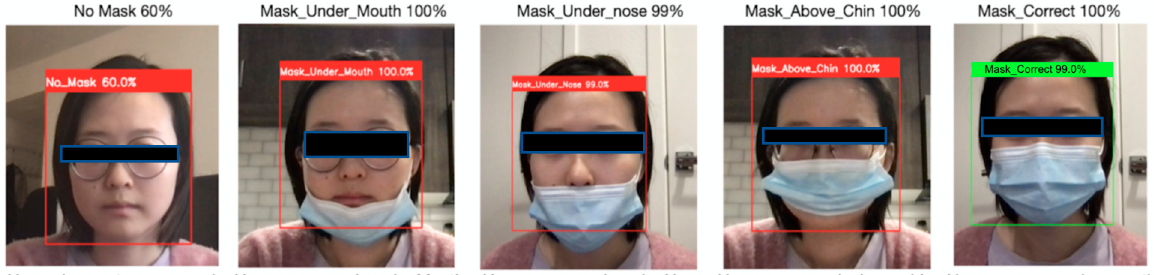
Figure 21. Mask Position Detection in different scenarios.